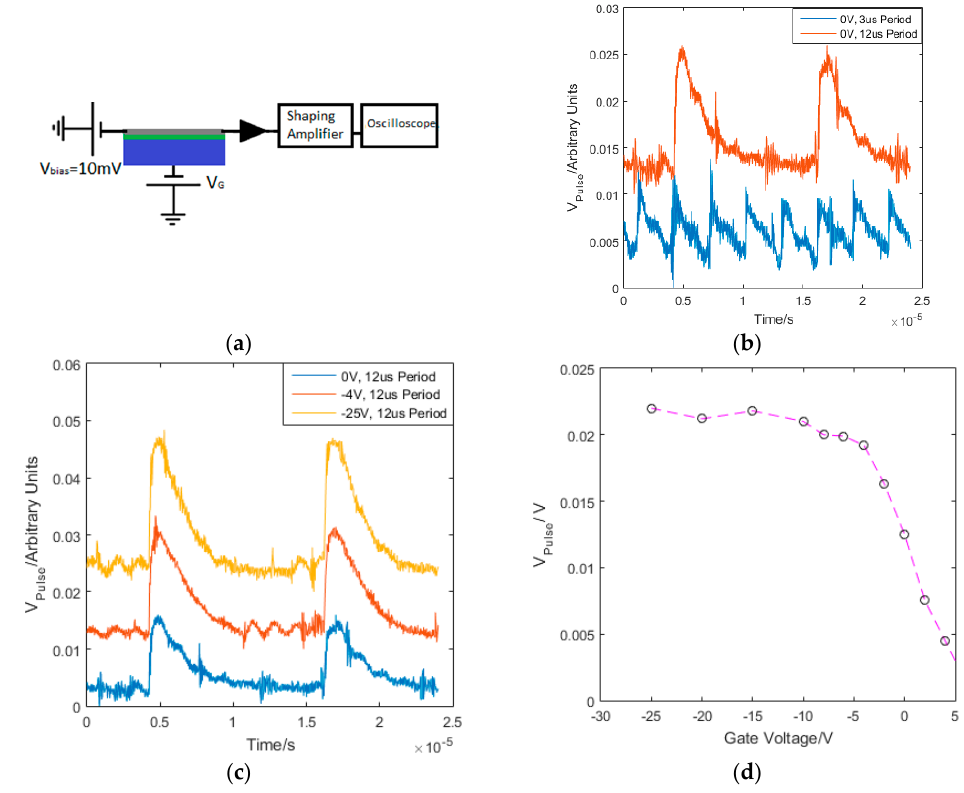
Figure 11. ( a ) the current sensitive preamplifier arrangement with the graphene (grey), SiO 2 (green) and Si (blue), with a 10 mV bias between the source and drain of the graphene and the output from the current sensitive preamplifier output on the oscilloscope ( b ) the dependence of the detector signal on the laser pulse frequency and ( c ) the gate voltage applied. N.B. periodic noise at ~ 200 kHz is also apparent. The detector signal has a very fast rise time and a fall time linked to the recombination time of the charge carriers in the silicon. ( d ) shows the dependence of the signal pulse height on the gate voltage, with a saturation point at approximately − 10 V attributed to limits on carrier transport in the Si given by SRH recombination.